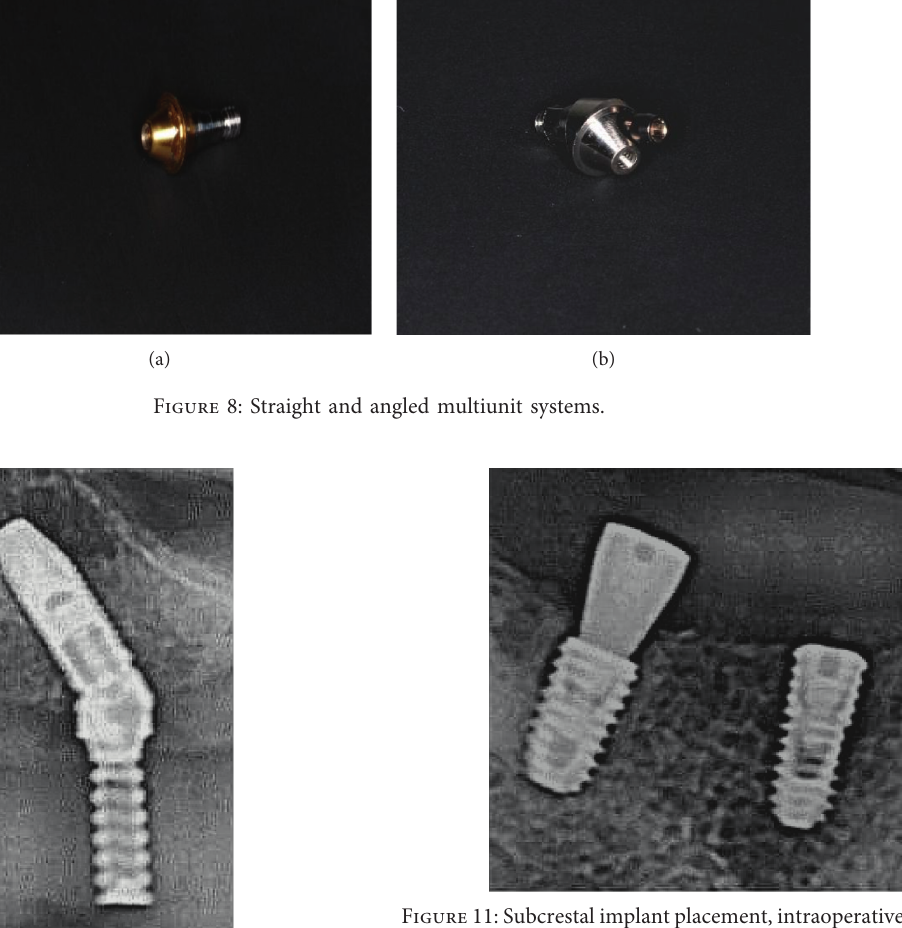
Figure 9: Radiographic control of the angled multiunit base fit into the implant.